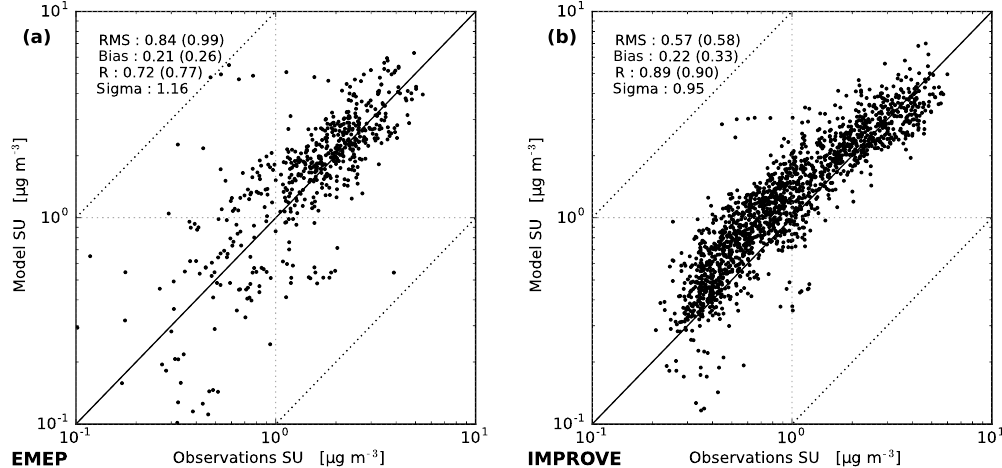
Figure 7. Scatter plots of yearly mean aerosol mass concentrations observed at EMEP (a) and IMPROVE (b) stations versus those from SALSA2.0 simulations for SU. The given statistical values are the same as in Fig.